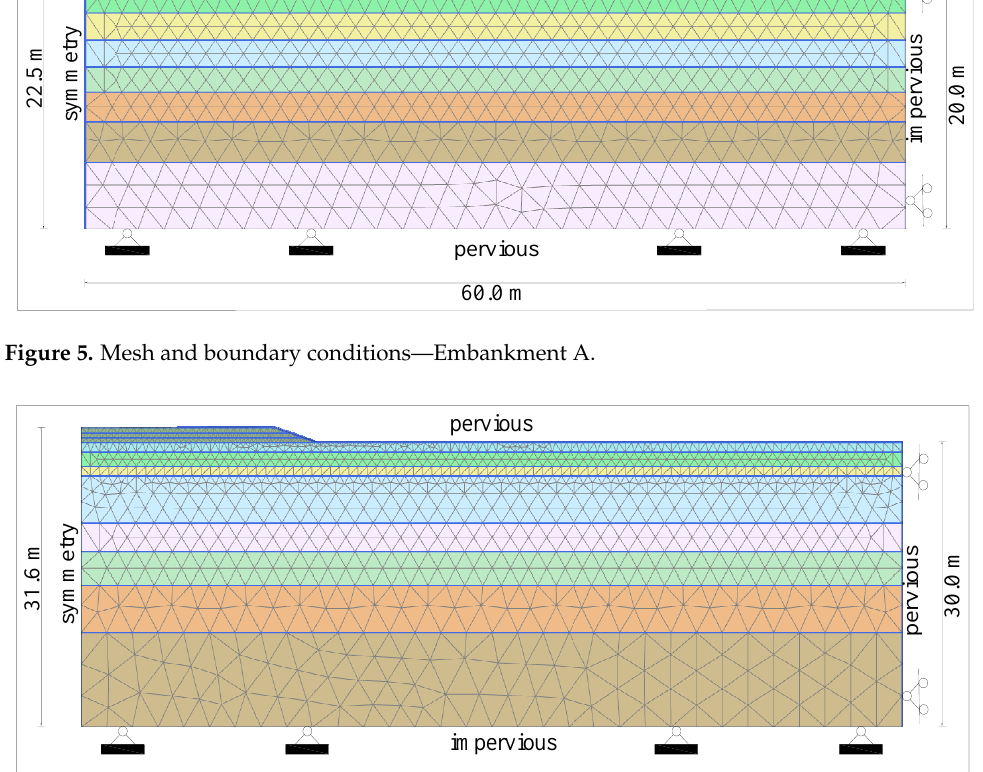
right boundaries, while vertical displacements were allowed. Also, the horizontal and vertical displacements were fixed at the bottom boundary for both